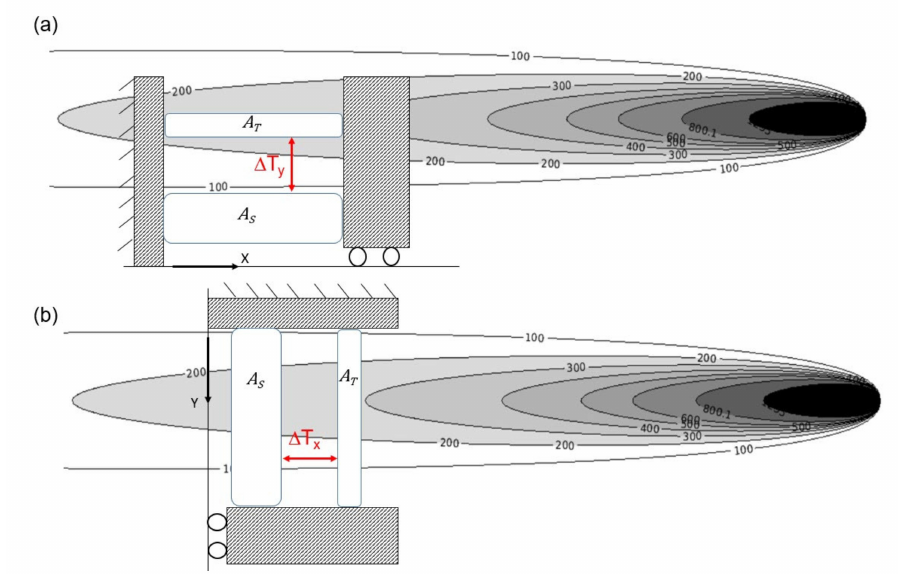
Figure 20. RS formation: ( a ) scan direction; ( b ) hatch